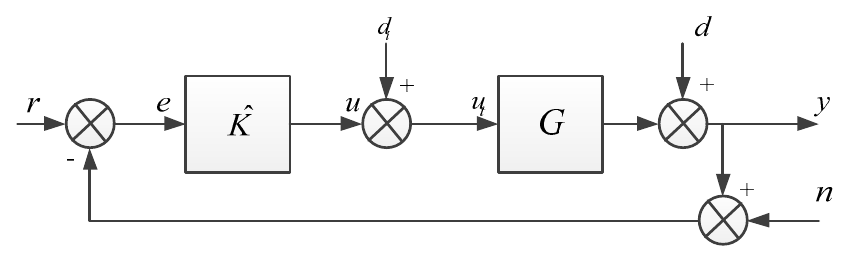
Figure 23. Loop-shaping controller diagram.